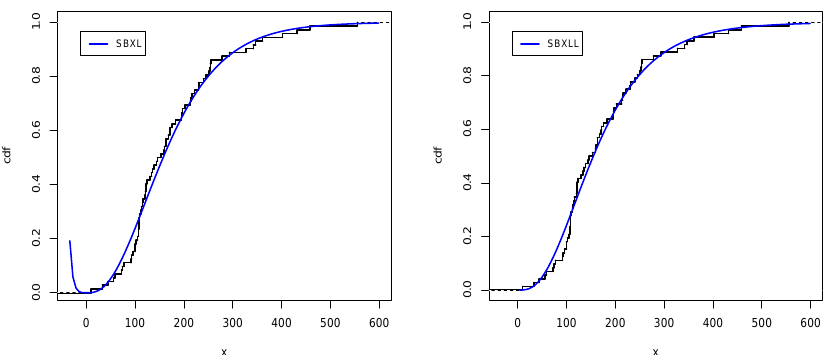
Figure 11. Plots of estimated pdf of SBXL and SBXLL models for data set V.